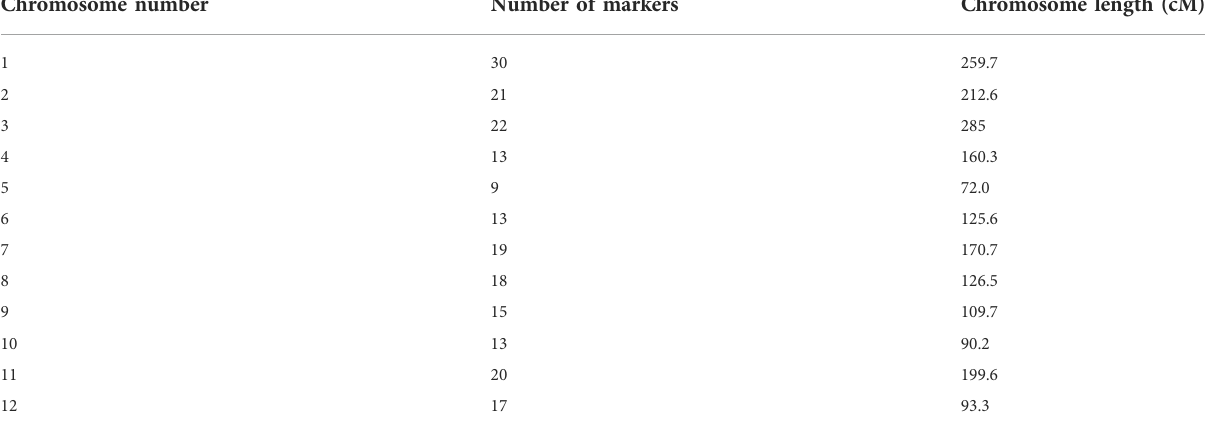
TABLE 2 Number of markers per chromosome and chromosome length in centiMorgen (cM).